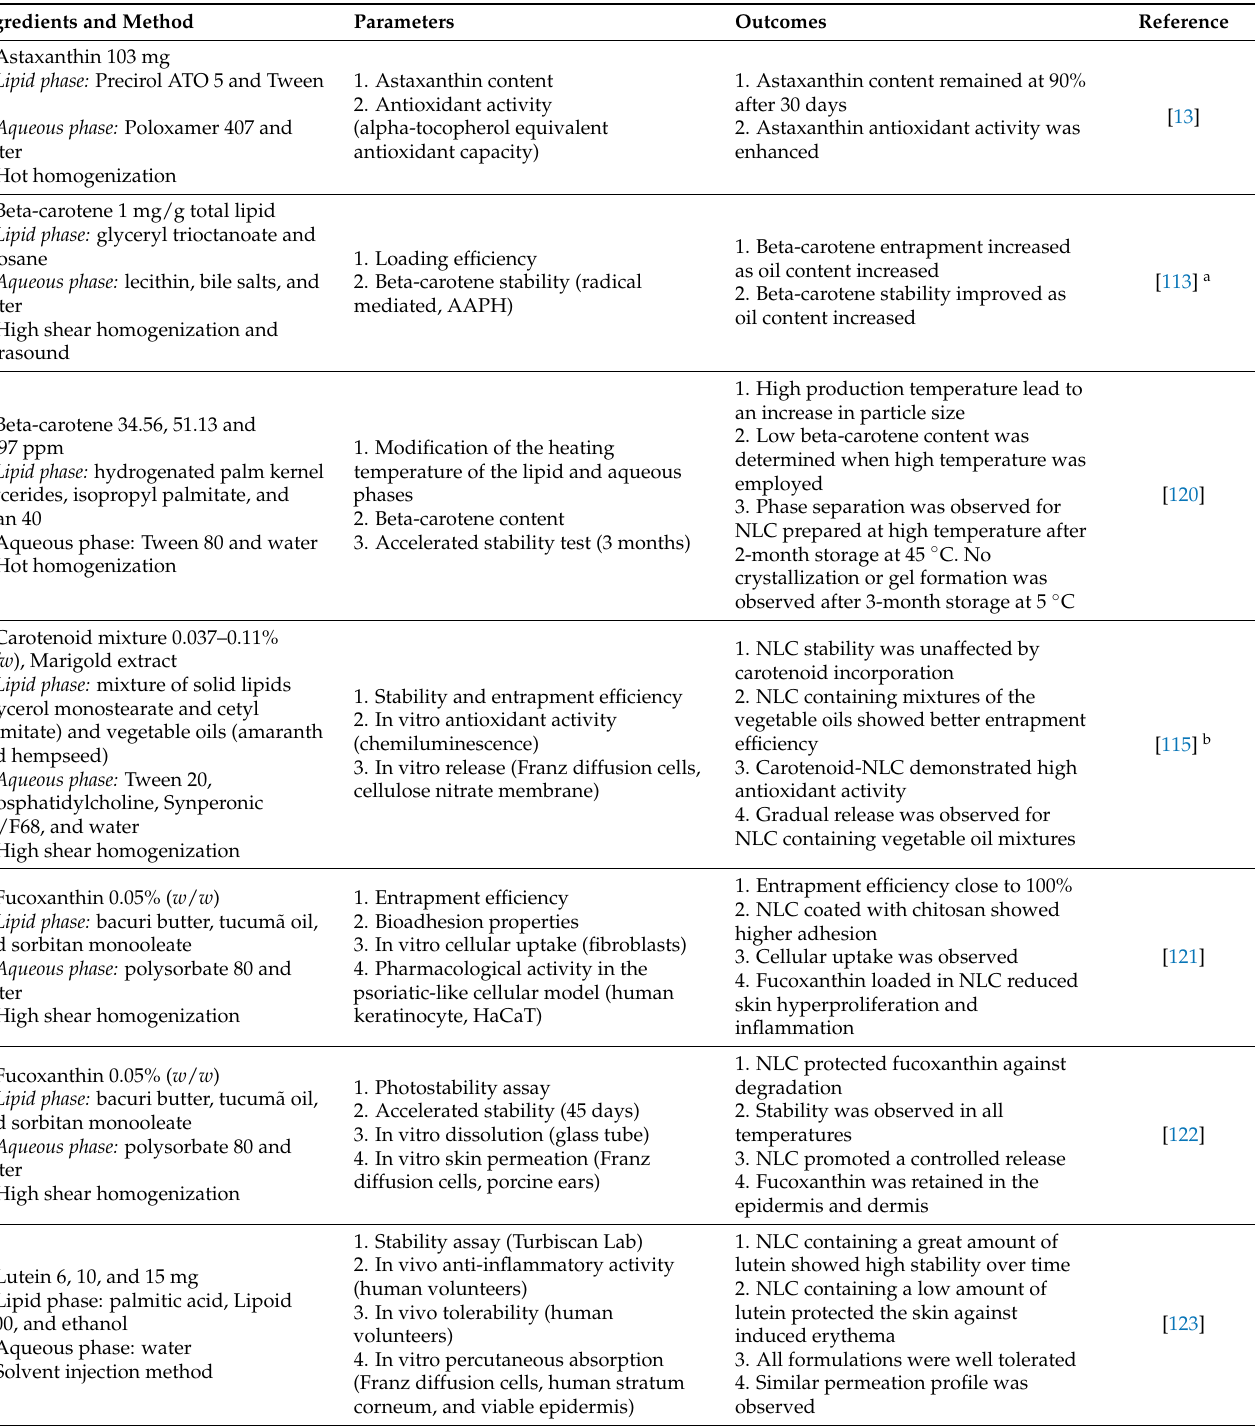
Table 4. Studies on carotenoid encapsulation in nanostructured lipid carriers (NLC) employing other preparation methods. Ingredients and